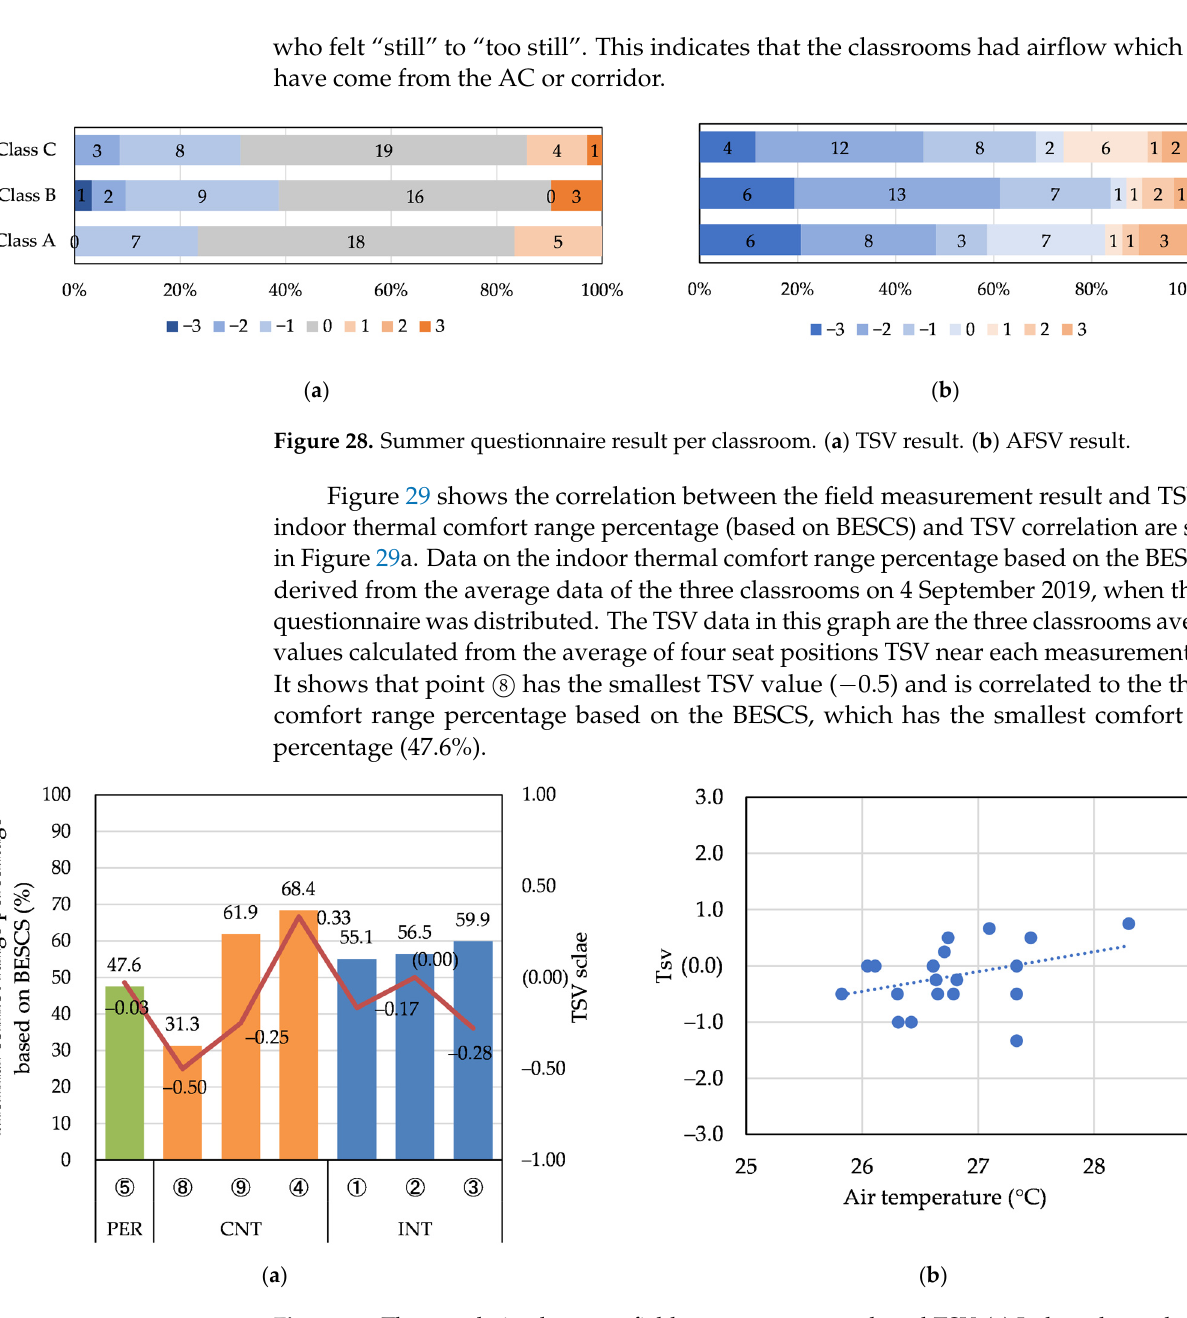
− 0.6 1 Four rows from left to right are window seats to corridor seats. 2 Three zones from left to right are PER, CNT, and INT. On the other hand, the highest AFSV average per zone scale result was in the PER zone, and the first row from the window for the highest AFSV average per row scale means that students who sat in that zone did not feel air flow as strong as in the other zones. However, similar to class A, the second row from the window had the lowest AFSV average per row. It can be presumed that this position is near the AC equipment that blows air directly to that position. Based on the average per-row result of the TSV in class C, the highest TSV was in the PER zone. Figure 27c shows that the air temperature in the INT zone is slightly higher than in the CNT zone except for the back row. Therefore, it can be said that the AC airflow blew directly to the CNT zone, which made the air temperature in CNT lower than in the other zones, and the AFSV in the CNT zone was lower than in the other zones.